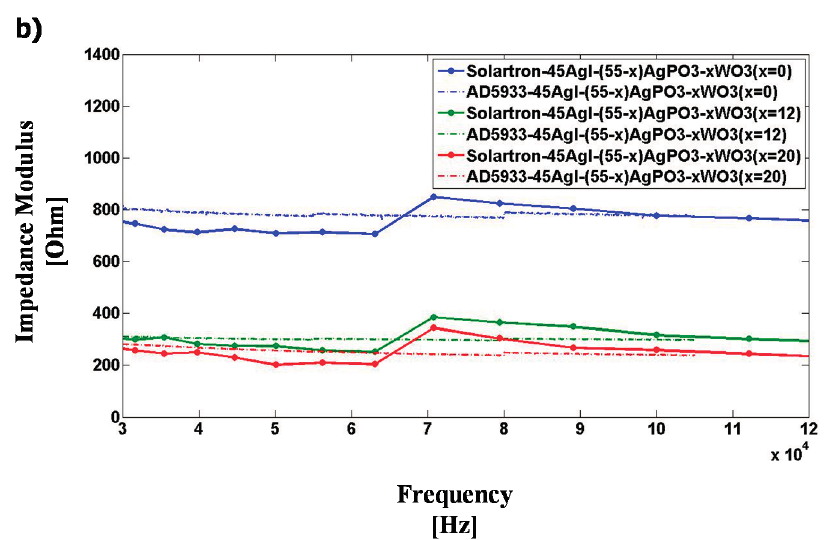
Figure 9. ( a ) Nyquist complex impedance of untouched 45AgI-(55- x )AgPO 3 - x WO 3 glasses, using 200 mV excitation voltage on the Solartron Impedance analyzer from 1 Hz to 1 MHz frequency; and ( b ) Comparative impedance results obtained using the Solartron Impedance analyzer and the DIS Platform featuring an AD5933 device.